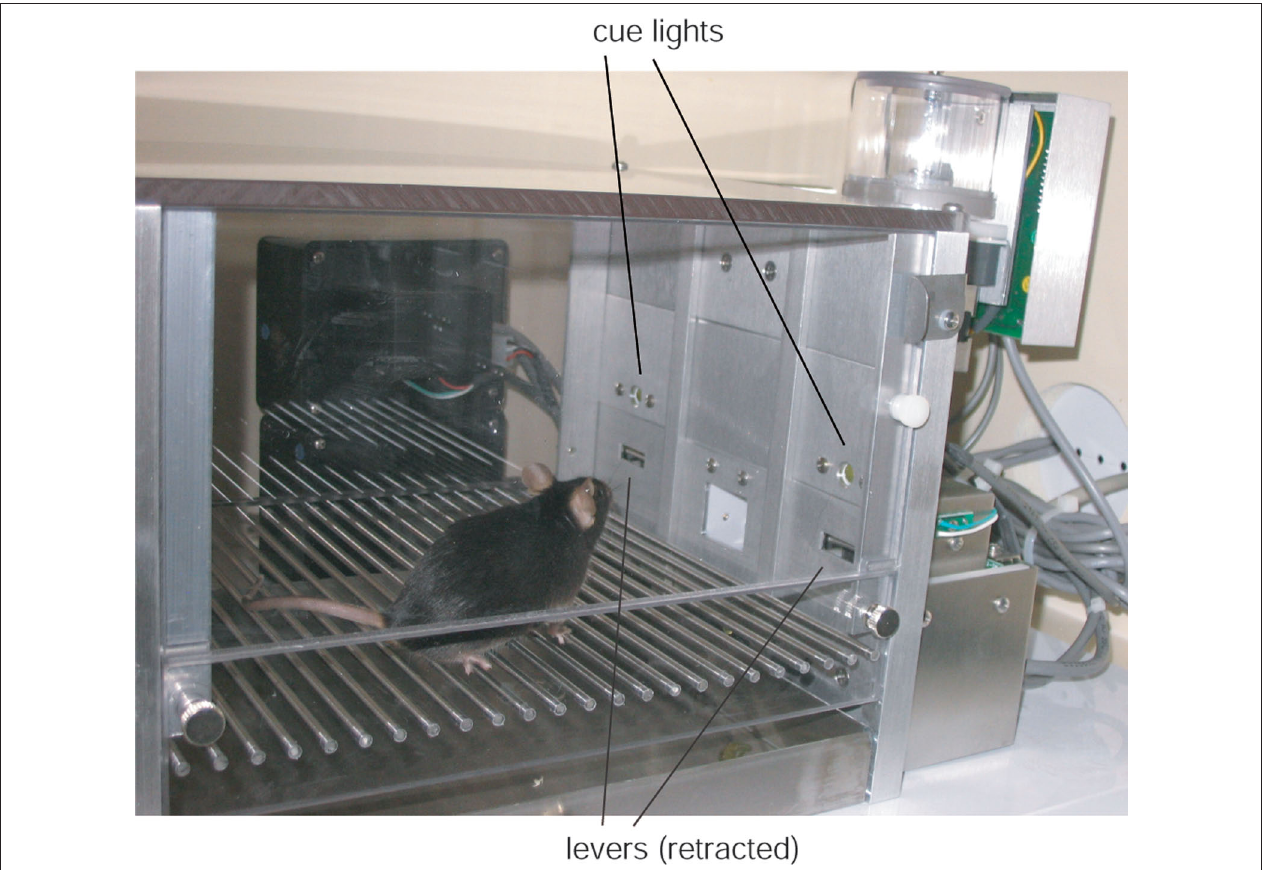
Figure 1 | Behavioral testing chamber. The behavioral box with stimulus lights, two operant levers (shown in the withdrawn state) and food magazine (in the middle) on the front